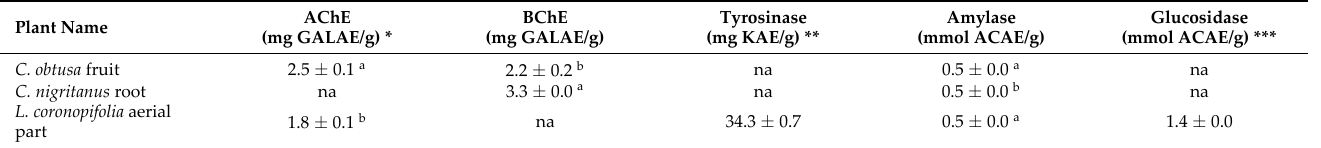
Table 5. Enzyme inhibitory activity of the essential oil of the investigated aromatic